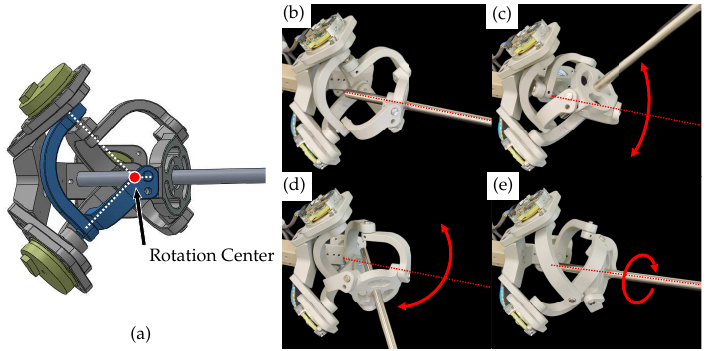
Figure 6. The rotational angle tracking structure based on the Agile Eye mechanism, (a) Linkage configuration of the one leg of the Agile Eye mechanism, (b) Neutral posture, (c) Pitch motion of the Agile Eye, (d) Yaw motion of the Agile Eye, (e) Roll motion of the Agile Eye.